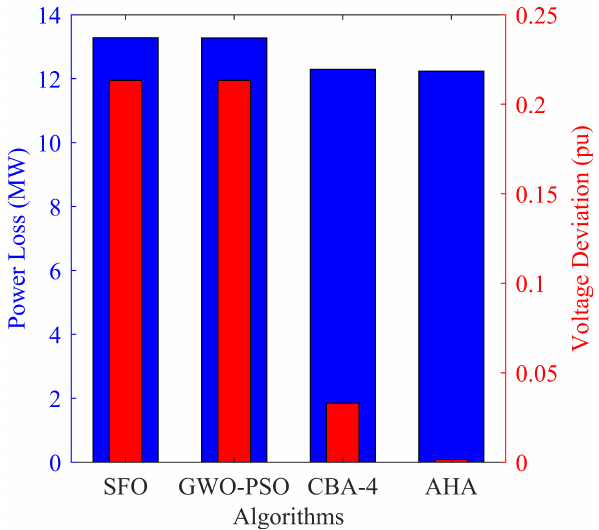
Figure 4. Comparison of P loss and V dev for IEEE 14 bus test system optimized using the proposed framework.